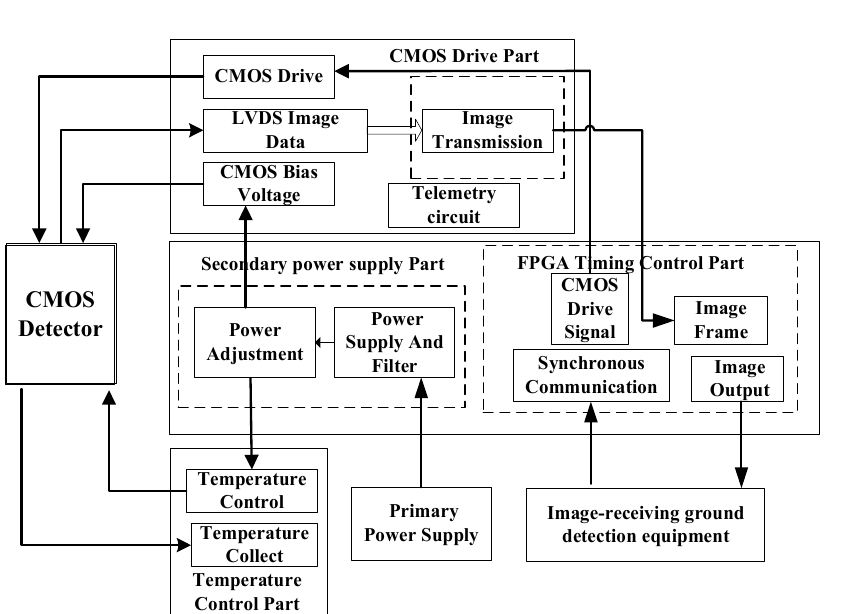
Figure 3. The camera prototype signal flow diagram.